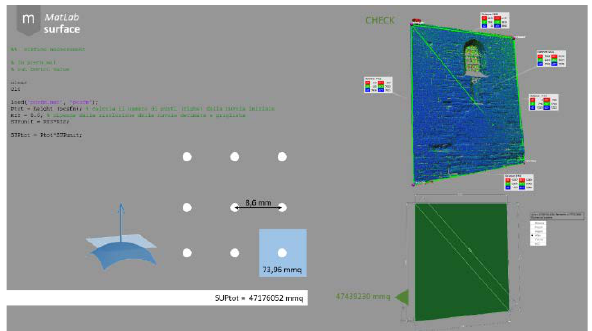
Figure 20. Calculation of real surface area starting on point cloud.